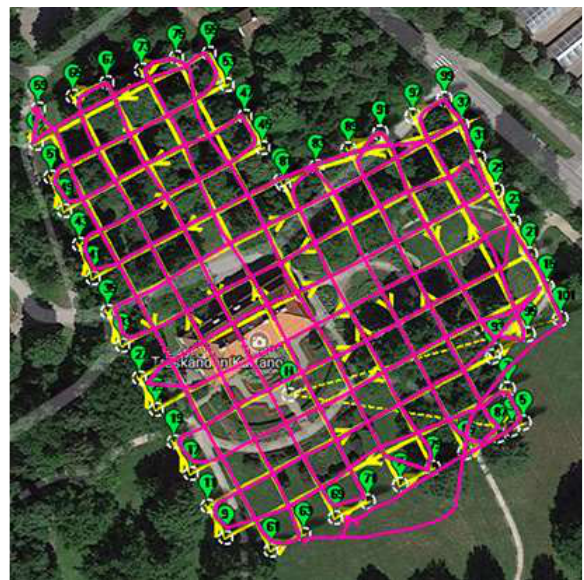
Figure 11. Flight plan and realised flight path of an example survey mission in Träskända. Planned flight path is shown in yellow and the drone flight path is illustrated in